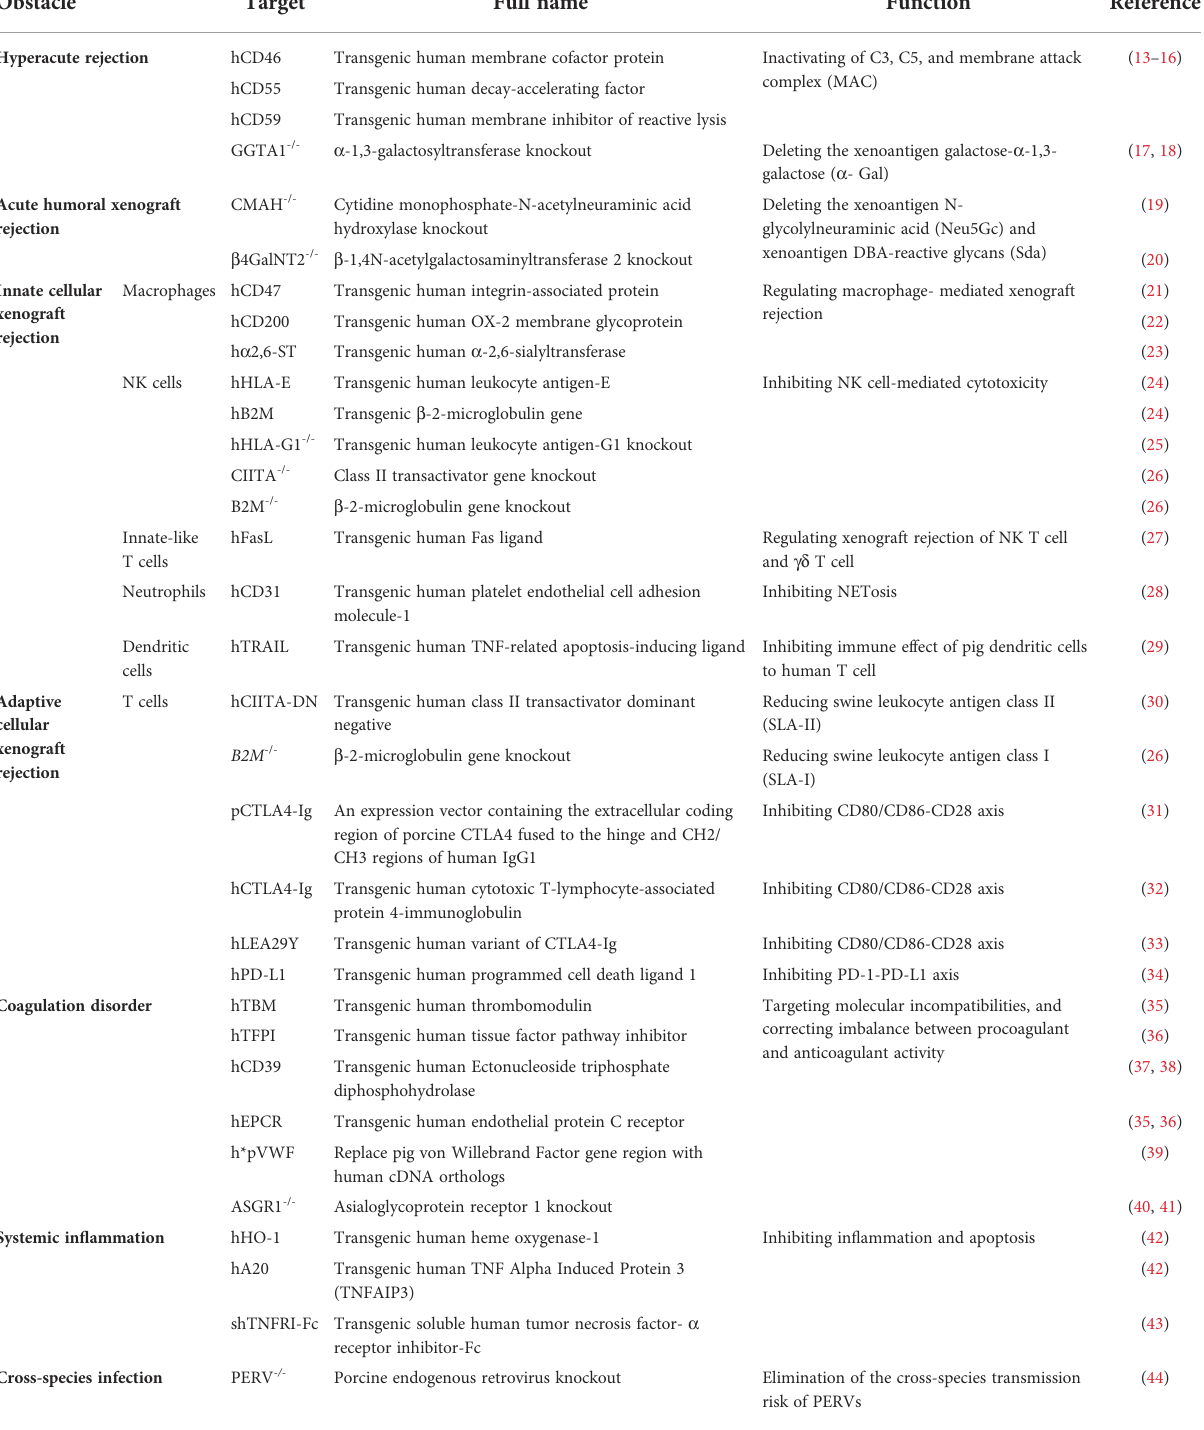
TABLE 2 Obstacles and relevant genetic modi fi cations in pig-to-primate xenotransplantation.